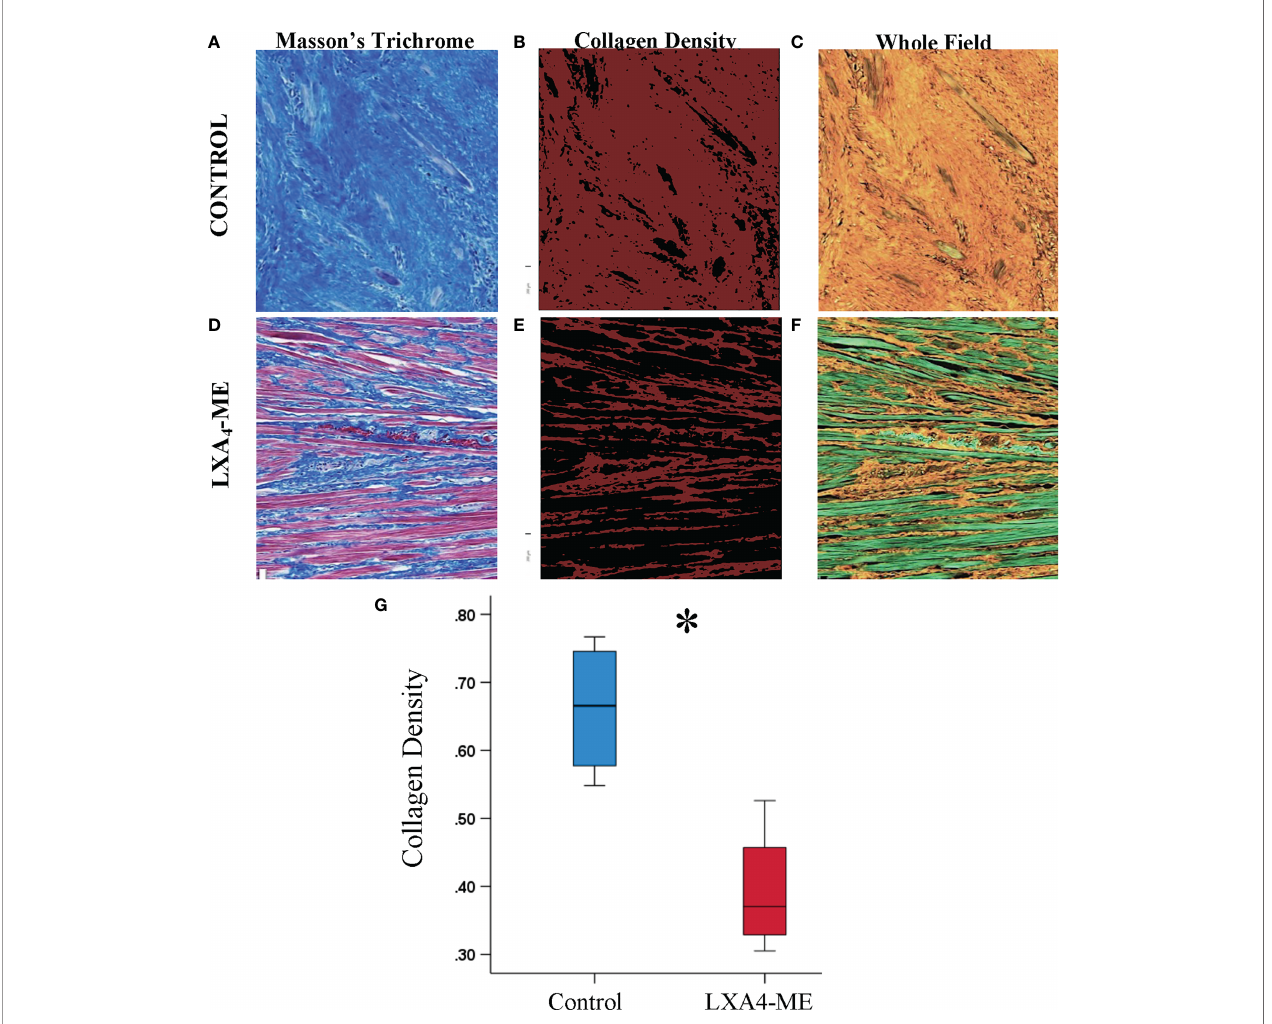
FIGURE 5 | Automated quanti fi cation of collagen fi ber density of JPEG images of representative tissue specimens stained with Masson ’ s Trichrome captured at 200x magni fi cation (A, D) . Collagen fi bers are coded red in images illustrating collagen density (B, E) or orange in whole fi eld images (C, F) . Automated quanti fi cation of collagen fi ber density using custom-written code in Matlab showed reduced collagen fi ber density in animals treated with LXA4-ME (median=0.37, 25 th ; 75 th percentile=0.34, 0.42) (E, F) compared to control animals treated with PBS (median=0.67, 25 th ; 75 th percentile=0.59, 0.74) (B, C) . The average of three regions per animal were used for statistical analysis (G) (*P < 0.05, Mann-Whitney U test; n=4 animals/group). The color bars for panel b and e are ranging from 0-1. The scale bars represent 100